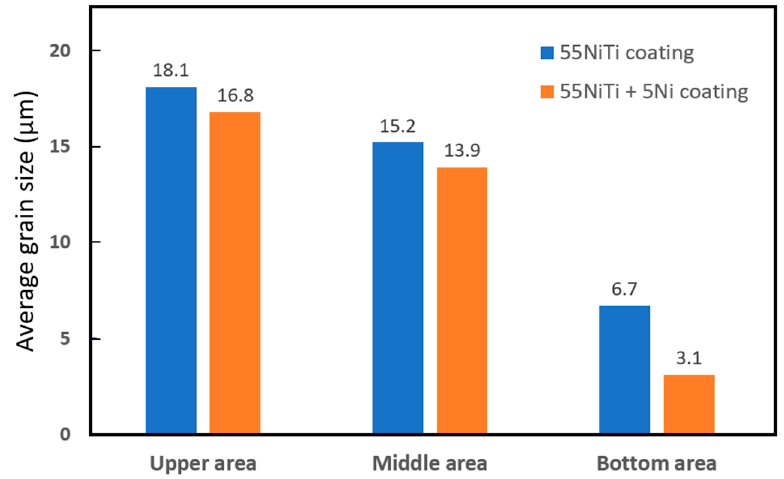
Figure 8. Distribution of the dendrite size in different areas of the coating.